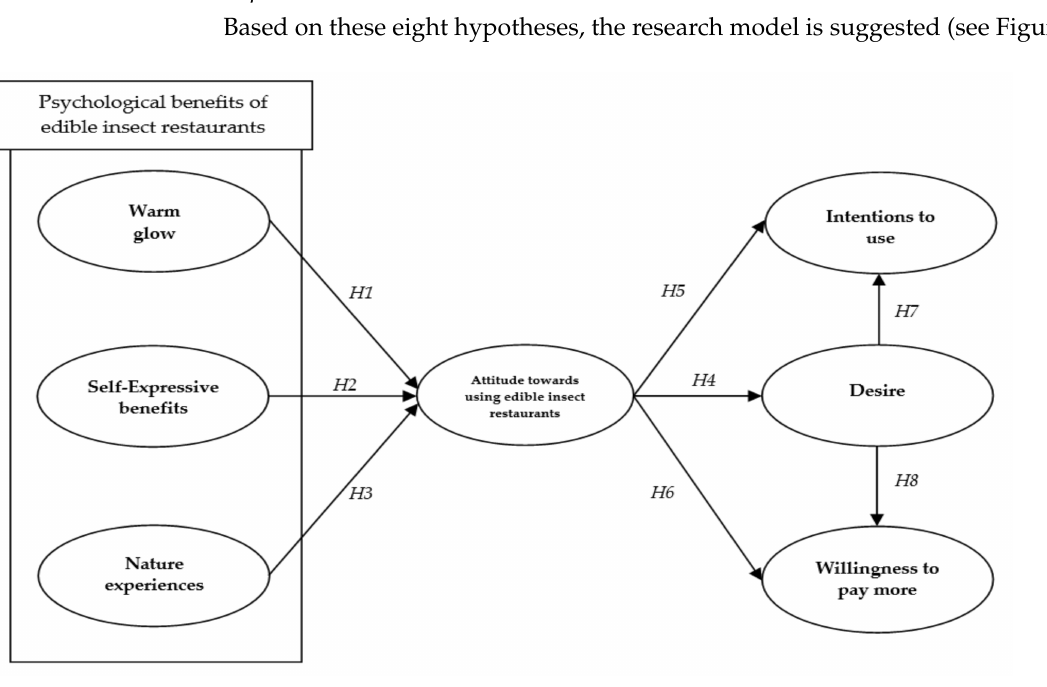
Figure 1. The proposed conceptual